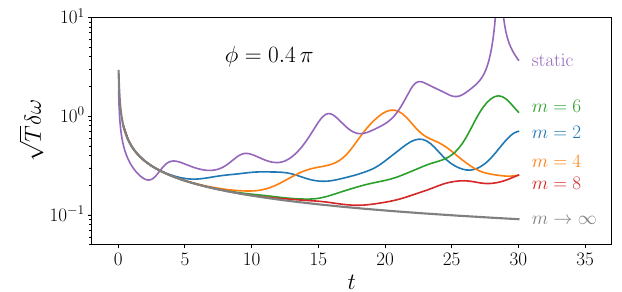
FIG. 5. Deviations from φ = π/ 2 (ideal DMI) can degrade the sensitivity in estimating a static parameter ω (purple line). Peri- odic π pulses can suppress the damaging XX interaction, extend the optimal sensing time, and enhance the sensitivity (in a modi- fied scheme to estimate the amplitude ω of an alternating signal). Here, we plot the error at time t , assuming that there have been m periodic π pulses ˆ V π (at the times t / m , 2 t / m , . . . , t ).